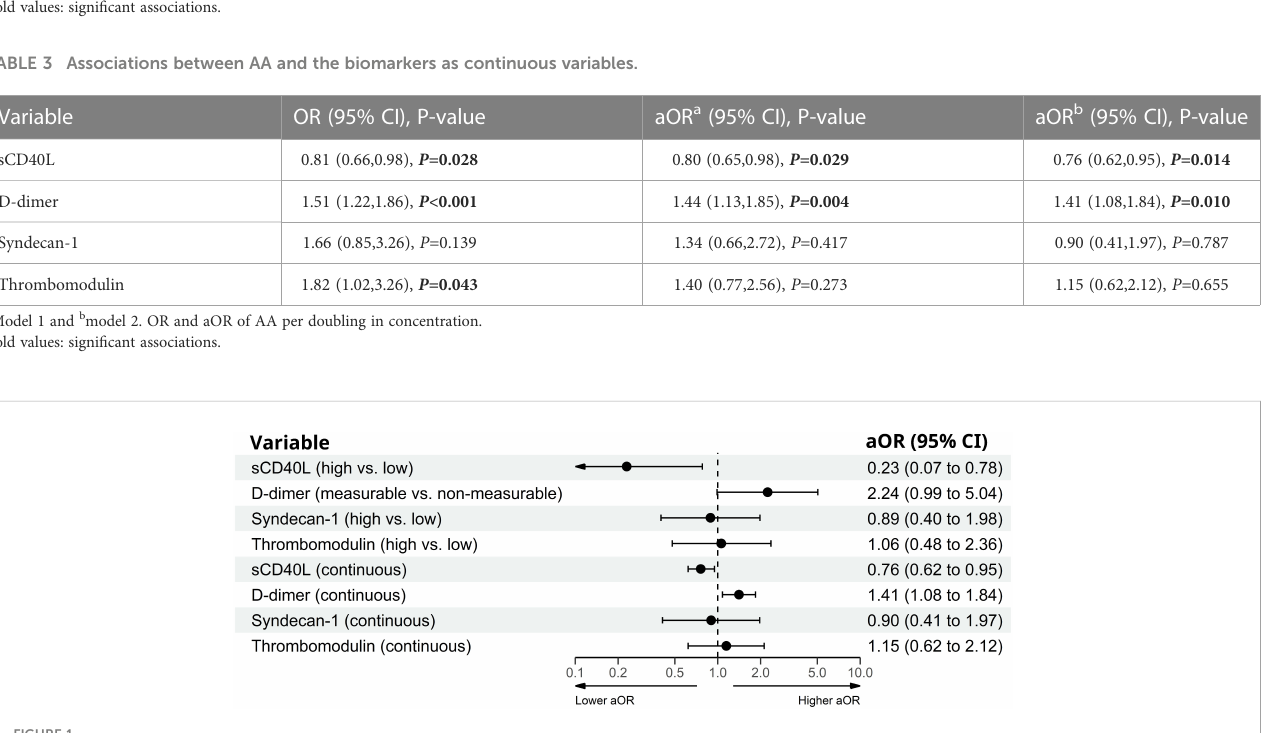
FIGURE 1 Primary (high vs. low variable) and exploratory (continuous variable, aOR associated with doubling of biomarker) analyses of the association between AA and the biomarkers in PLWH adjusted for age, sex, hypertension, smoking status, and BMI category.